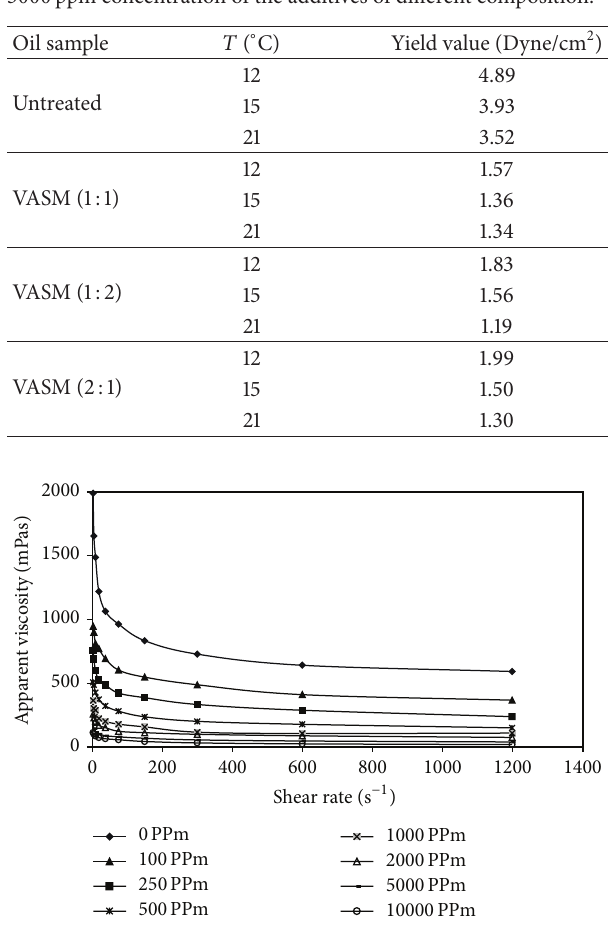
Table 6: Yield value of untreated and treated crude oil with 5000 ppm concentration of the additives of different composition.